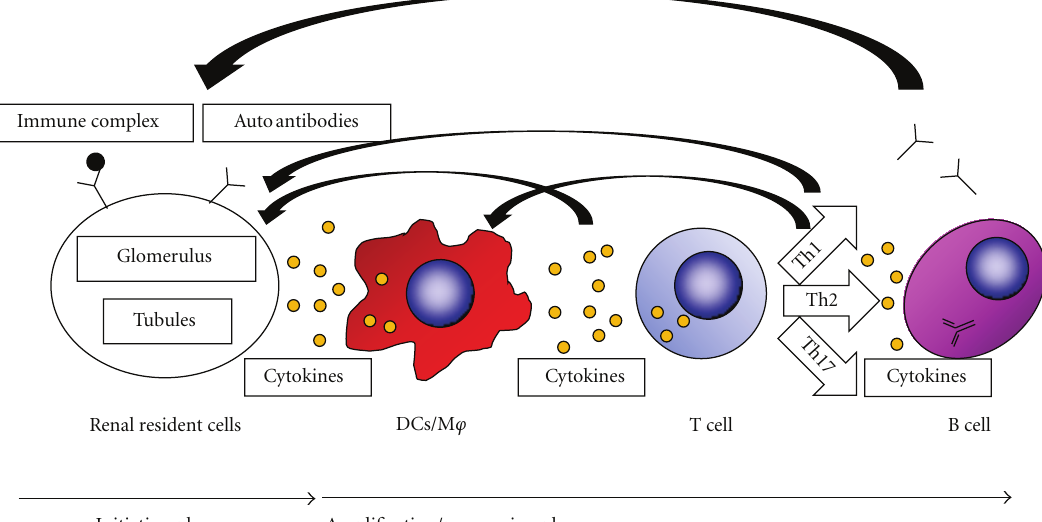
Figure 2: Cytokines contribute to the pathogenesis of lupus nephritis from the initiation phase to the amplification/progression phase. Immune deposits and/or autoantibodies induce the secretion of cytokine in the renal resident cells, which promote the infiltration and activation of leukocytes in the disease initiation phase. Activated leukocytes also produce cytokines, which leads to the further immune response in the disease amplification/progression